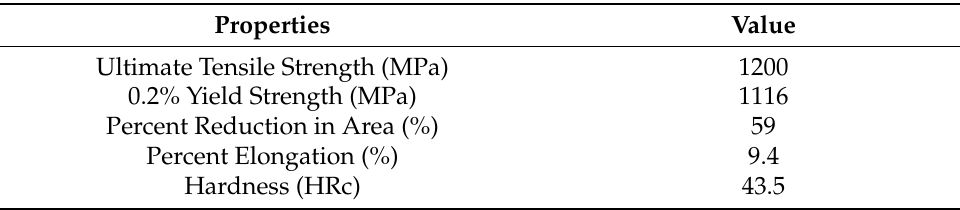
Table 2. Mechanical properties of AISI 4340.